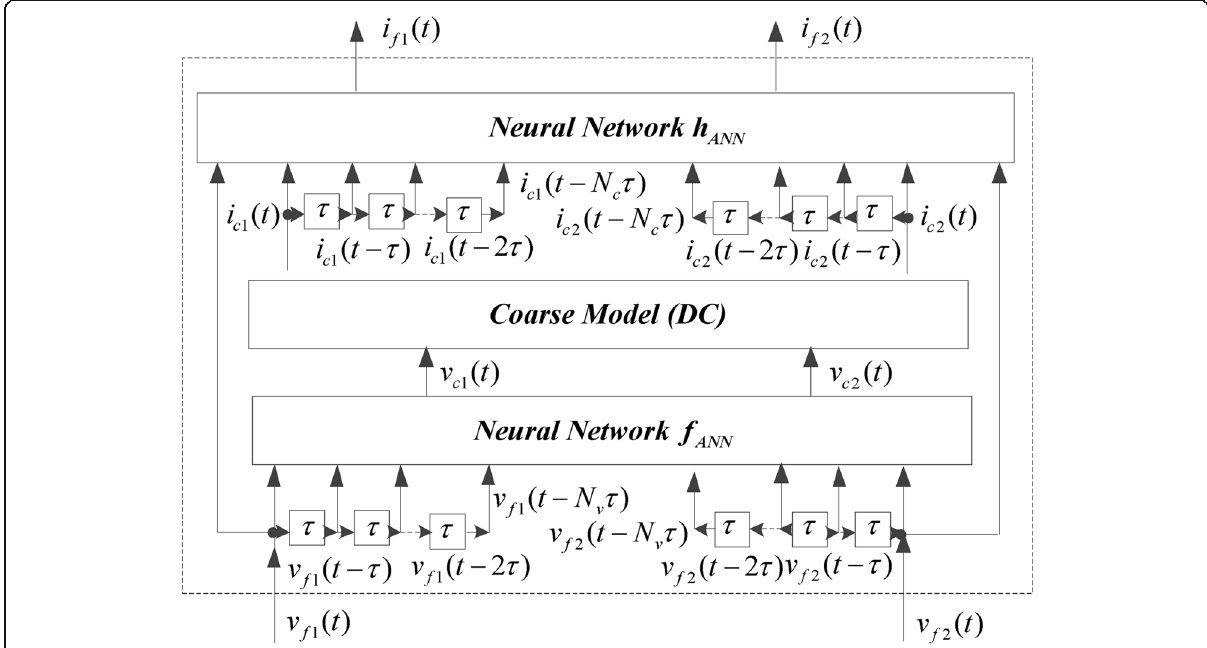
Fig. 1 Signal flow of the general Neuro-SM